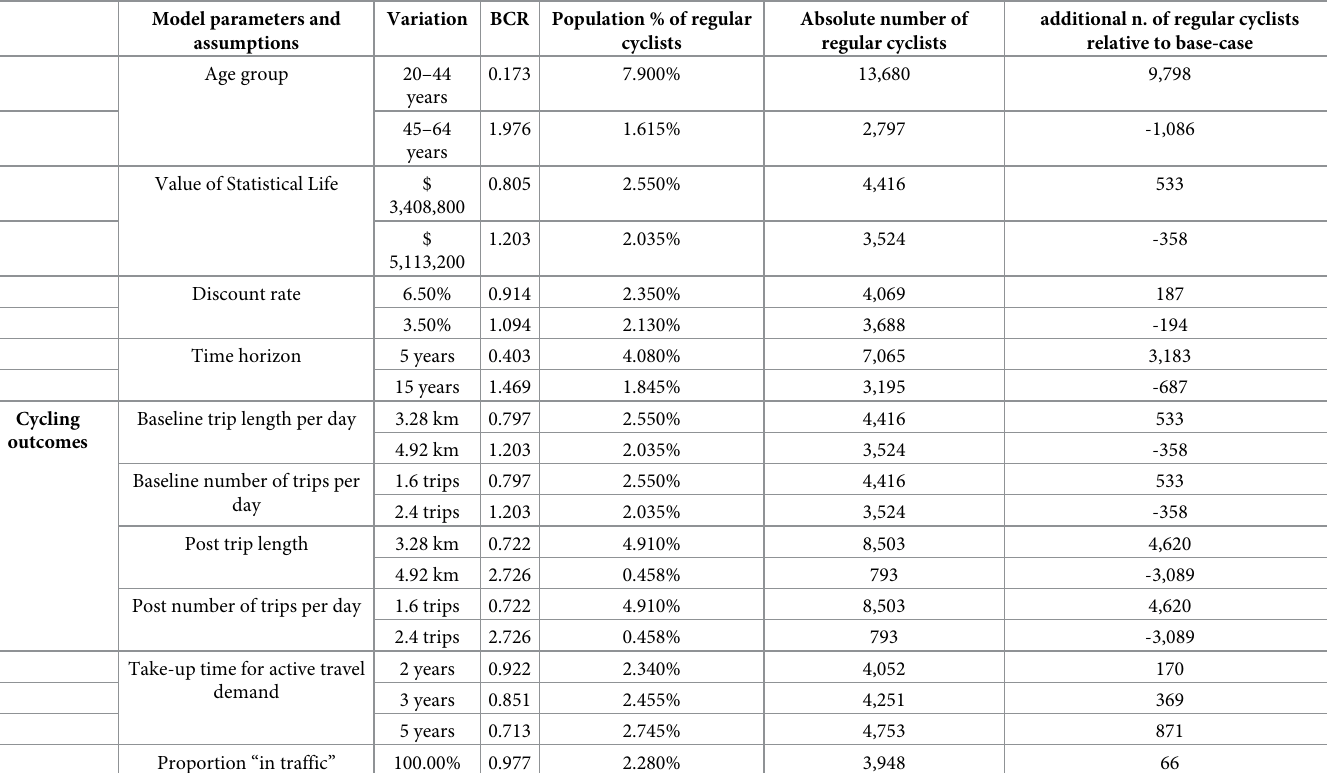
Table 3. Sensitivity